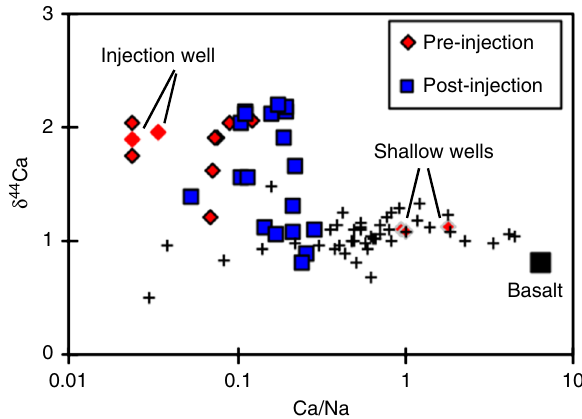
Fig. 1 Ca isotopes as a function of Ca/Na ratios. Elemental/Na ratios theoretically represent the uptake of the element in question by secondary minerals, relative to the highly mobile Na cation. The red diamonds with grey outlines represent the shallow groundwaters, while the pure red diamonds represent the injection well. Black crosses are previously measured Icelandic rivers and groundwaters 14,15 . Pre-injection samples are from a range of monitoring wells, while post-injection samples are a time